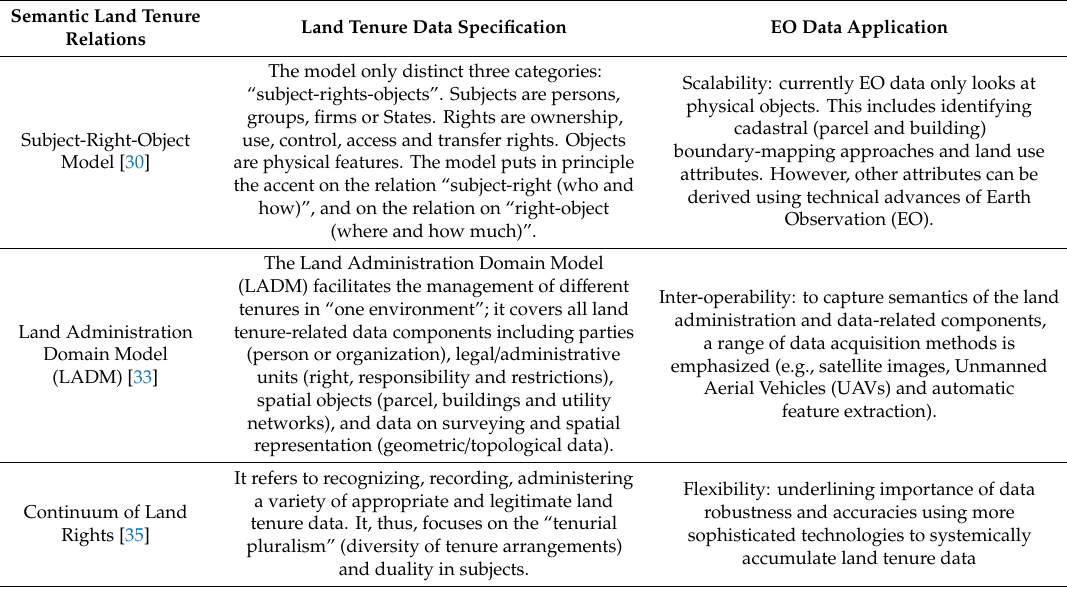
Table 1. The conceptual models of semantic land tenure